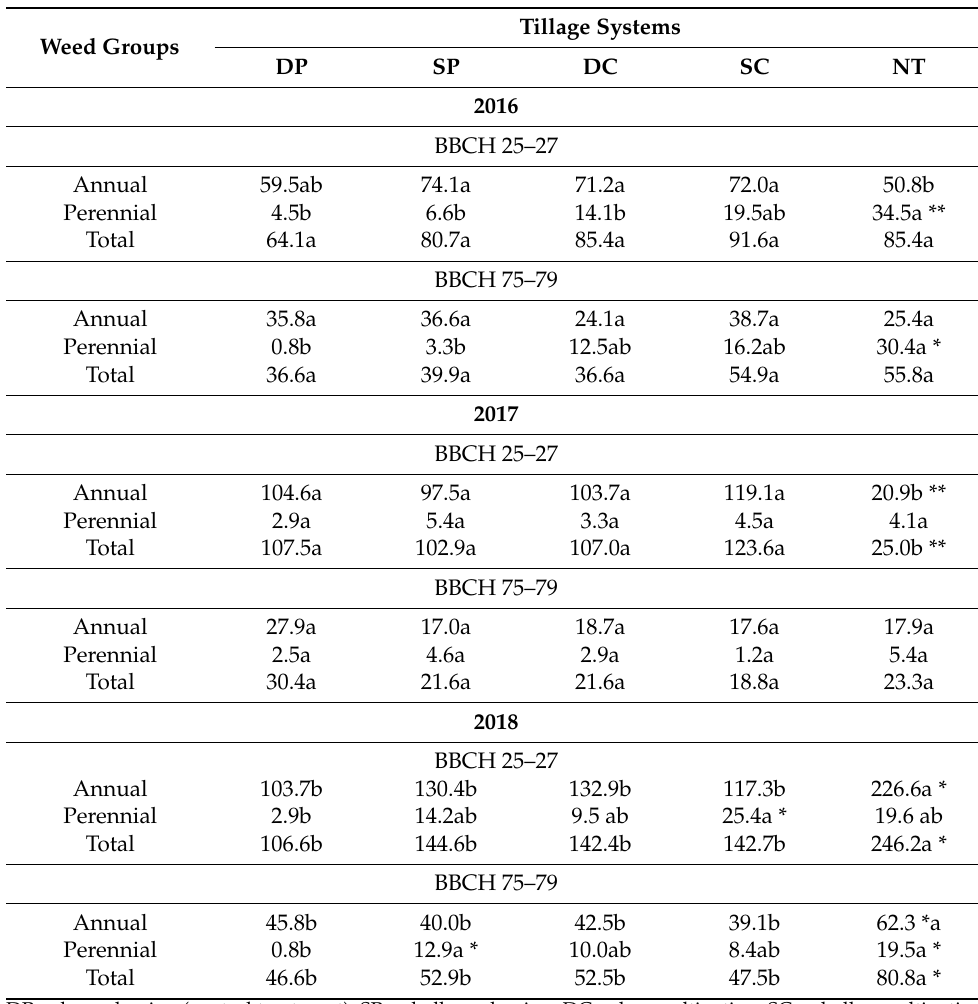
Table 1. Weed density (number m − 2 ) at different faba bean growth stages, as influenced by the tillage system in